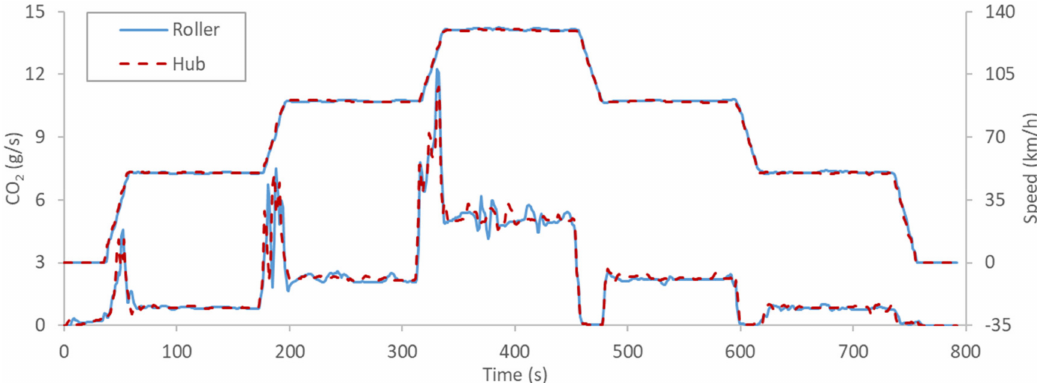
Figure A1. CO 2 real-time emissions during the speed ramp tests.